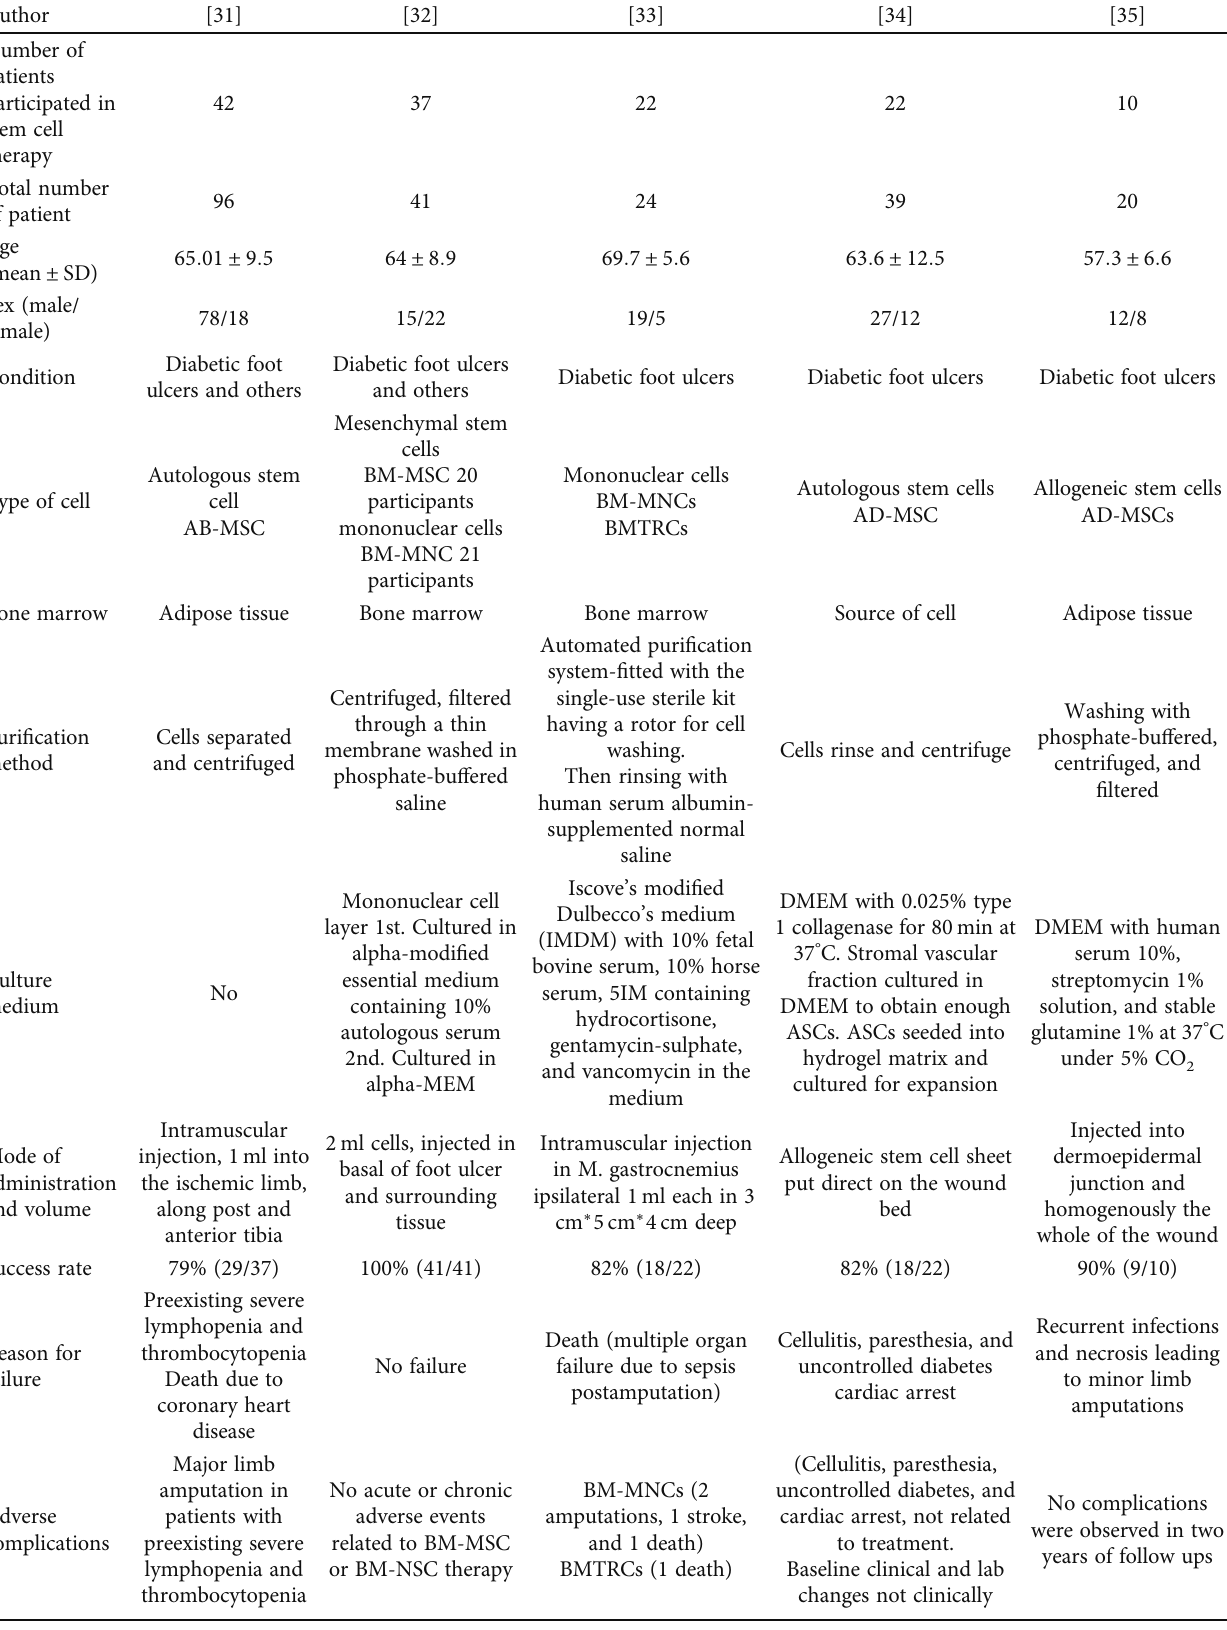
Table 2: Selected studies with participants, cells employed, cell origin, cohort size, events, and